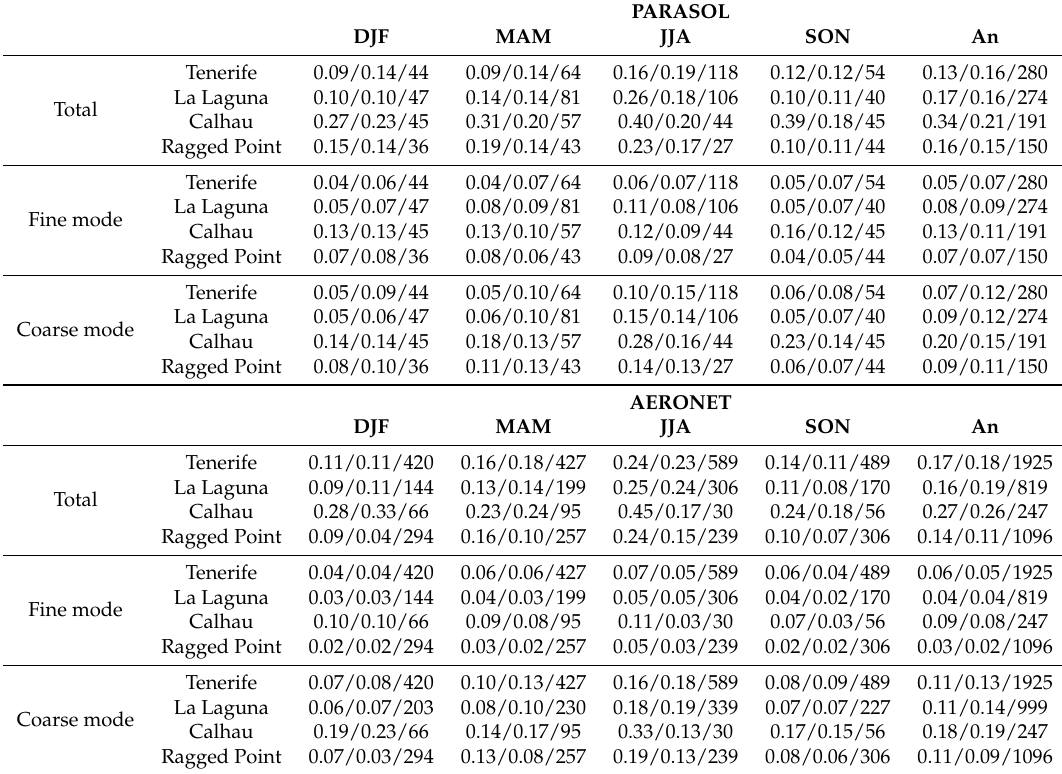
Table 2. AOD/ σ (standard deviation)/number of observations from PARASOL observations and AERONET measurements at 550 nm averaged from 2005 to